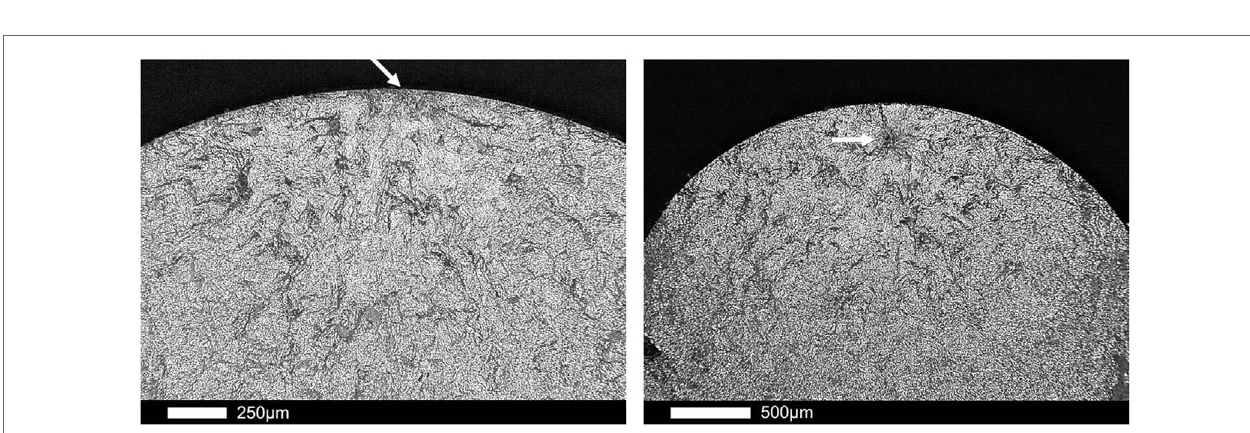
FigUre 5 | crack initiation site for hot-isostatic-pressed specimen under tension–tension loading; surface crack initiation at N f = 2.9 × 10 5 (left) and internal crack initiation at N f = 2.4 × 10 6 (right)